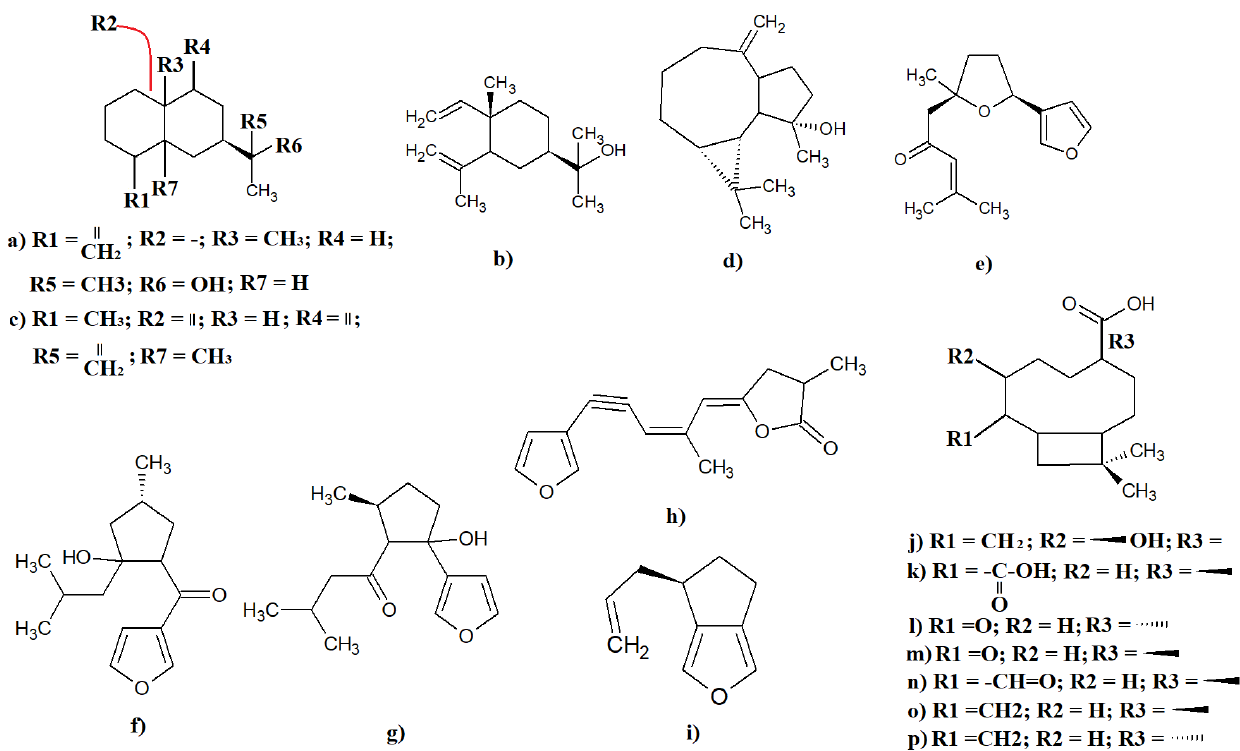
Figure 4. Selected sesquiterpenoids identified in Eremophila spp.: ( a ) elemol; ( b ) eudesmol; ( c ) ere- mophilone; ( d ) spathulenol; ( e ) 10,11-dehydrongaione; ( f ) 9-hydroxydihydromyomontanone; ( g ) 4- hydroxydihydromyodesmone; ( h ) freelingyne; ( i ) genifuranal; ( j ) (1,4,7,9)-7-hydroxy-11,11-dimethyl- 8-methylenebicyclo[7.2.0]undecane-4-carboxylic acid; ( k ) (1,6,9)-10,10-dimethylbicyclo[7.2.0]undec-2- ene-2,6-dicarboxylic acid; ( l ) (1,4,9)-11,11-dimethyl-8-oxobicyclo[7.2.0]undecane-4-carboxylic acid; ( m ) (1,4,9)-11,11-dimethyl-8-oxobicyclo[7.2.0]undecane-4-carboxylic acid; ( n ) (1,4,9)-8-formyl-11,11-dimethylbicyclo[7.2.0]undec-7-ene-4-carboxylic acid; ( o ) (1,4,9)-11,11-dime- thyl-8-methylenebicyclo[7.2.0]undecane-4-carboxylic acid; and ( p ) (1,4,9)-11,11-dimethyl-8-meth- ylenebicyclo[7.2.0]undecane-4-carboxylic acid.